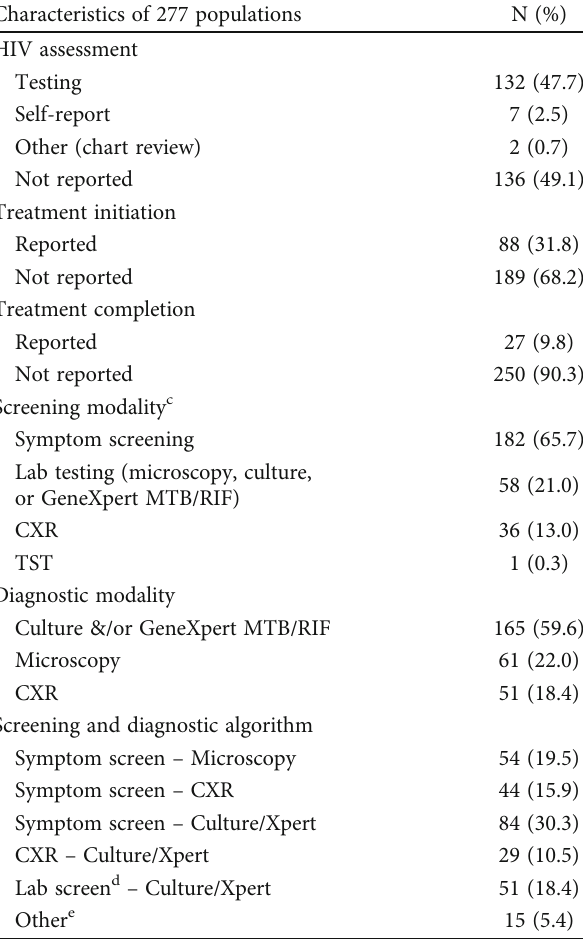
Table 1: (a) Characteristics of 224 Studies, (b) Characteristics of 277 unique populations within the 224